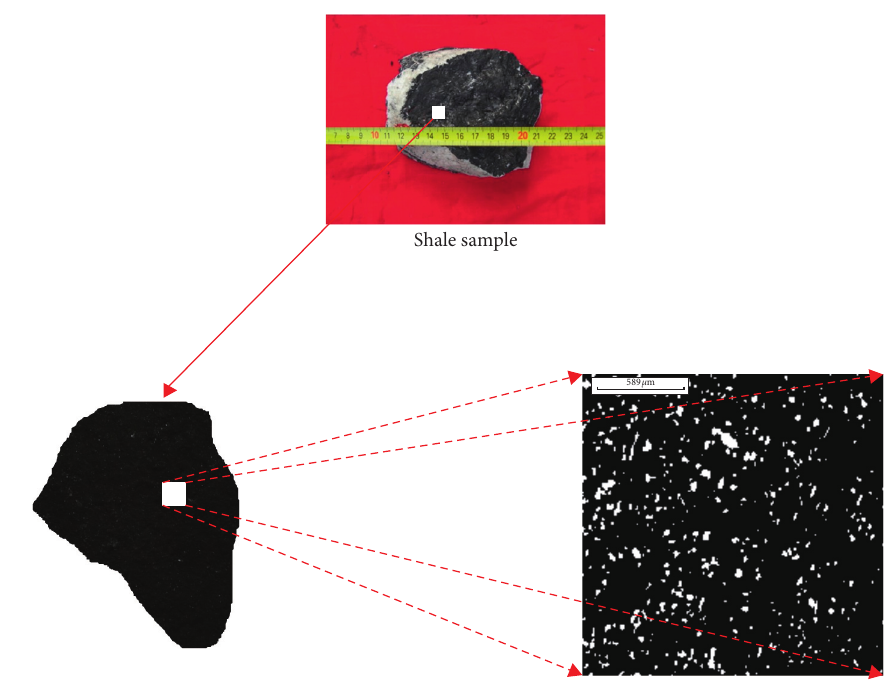
Figure 3: Thin slice of shale core under microscope.